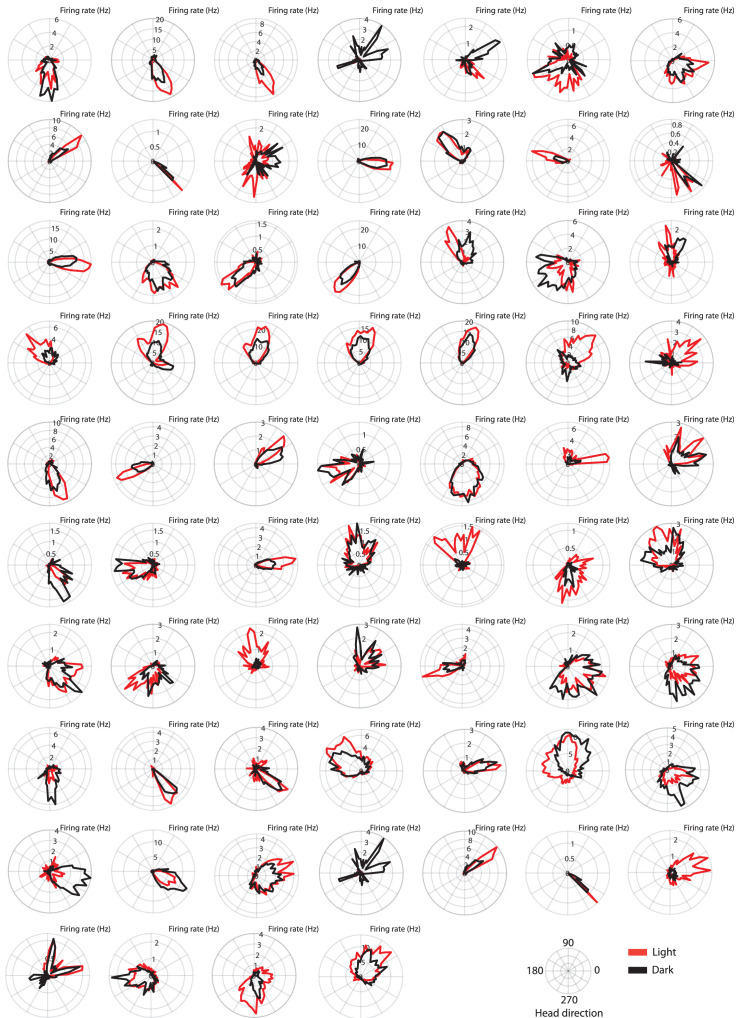
Polar histograms showing the head directional tuning in light and dark conditions of the 69 head direction cells analyzed in this study.Note that in the dark condition, head direction cells maintain tuning to their preferred head direction angles, but tuning curves become slightly broader. Note also that, in addition to tuning curves becoming broader, mean firing rates are often changed between light and dark conditions.